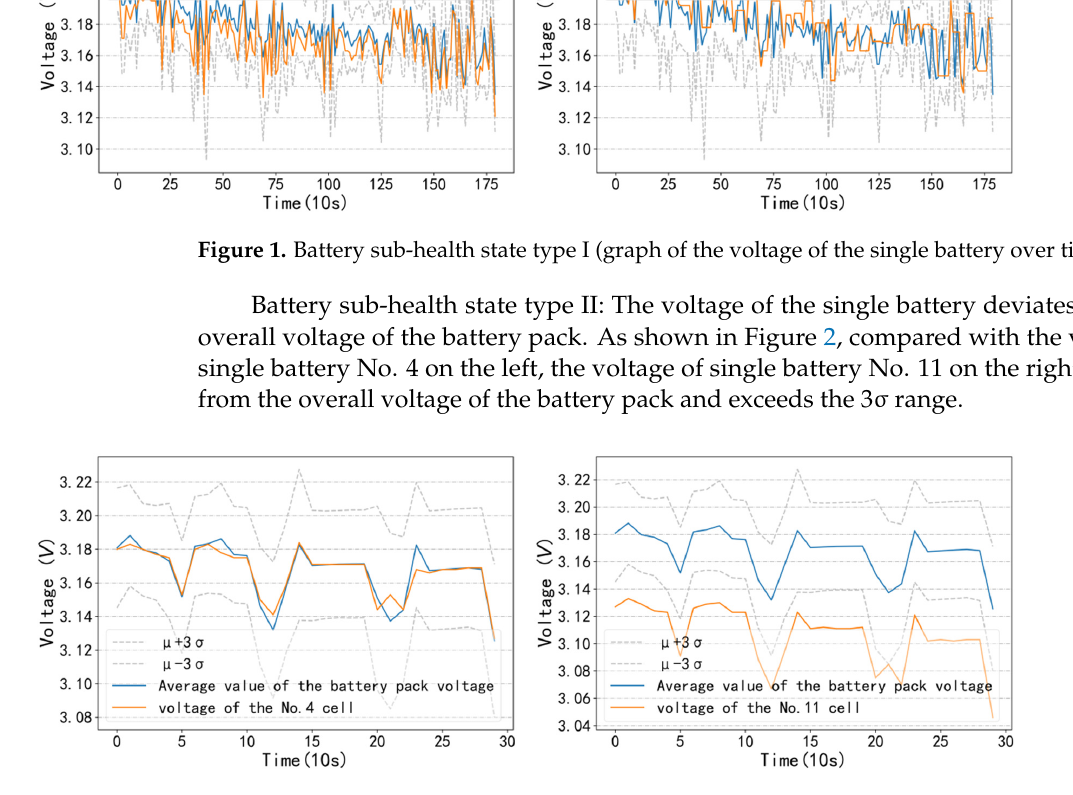
Figure 2. Battery sub-health state type II (graph of the voltage of the single battery over time).